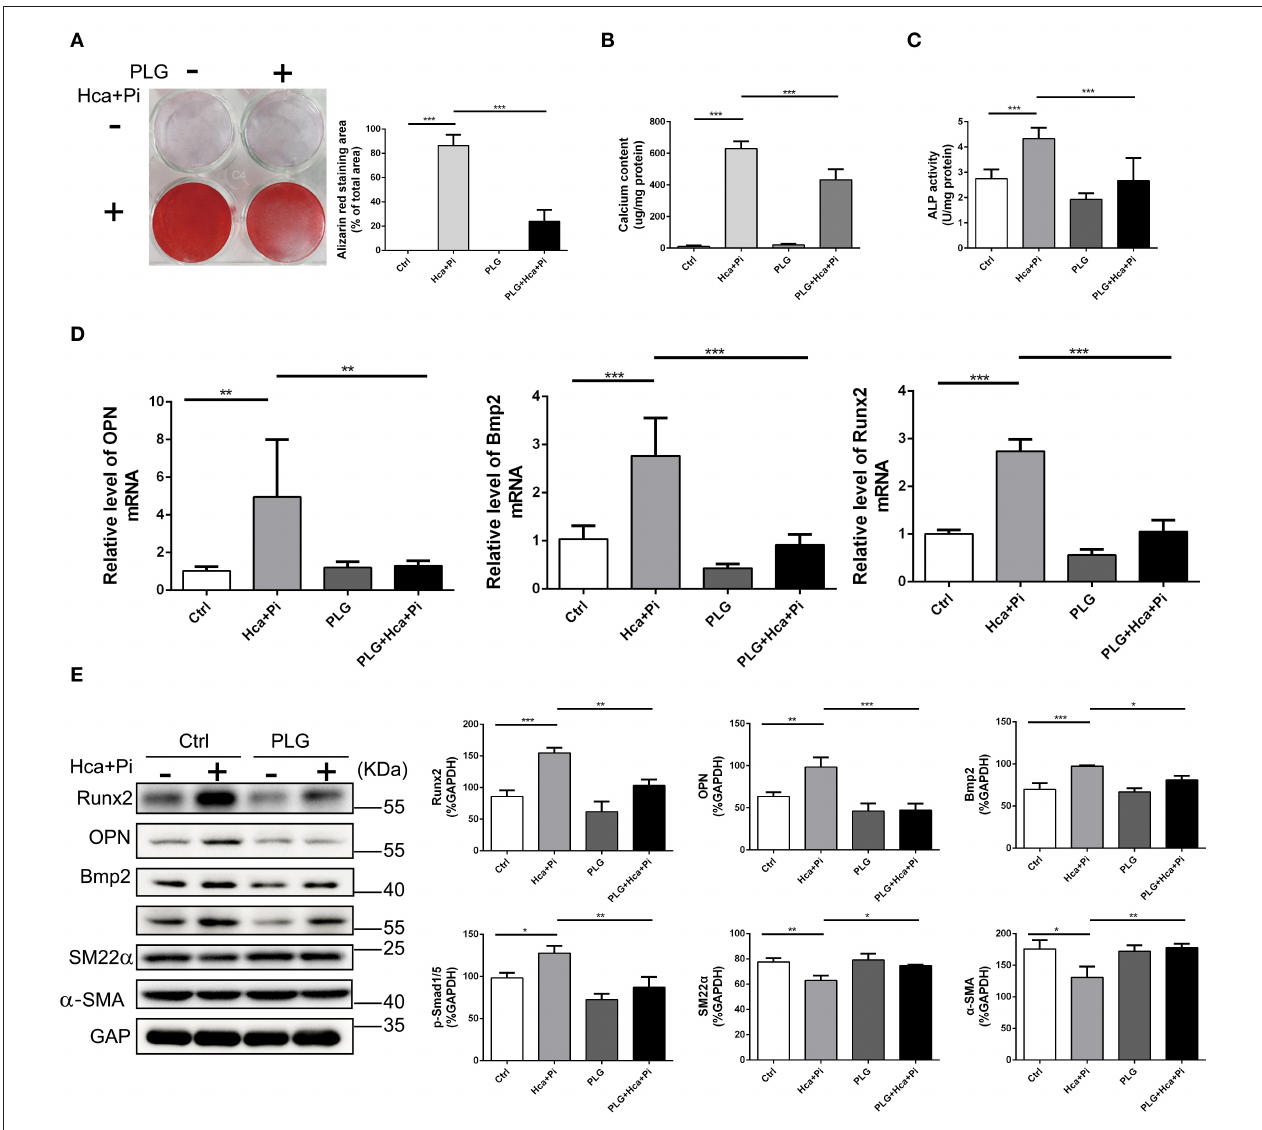
FIGURE 2 | PLG inhibits VSMCs calcification induced by high calcium/phosphate medium. (A) Alizarin Red staining of cellular calcium deposition. The histogram on the right is a statistical analysis of the Alizarin Red staining area. (B) Calcium content was measured with the QuantiChrom TM Calcium Assay Kit. (C) ALP activity was measured with the LabAssay TM ALP Kit. (D) RVSMCs were treated with PLG (2.5 µ M) and high calcium/phosphate. The mRNA levels of Runx2, OPN, and Bmp2 were measured by qRT-PCR ( n = 6 for each group). (E) The protein levels of Runx2, OPN, Bmp2, p-Smad1/5, SM22 α , and α -SMA were measured by western blotting. The relative protein levels were normalized to the level of GAPDH. The data are shown as the mean ± standard error of triplicate sets and are representative of three independent experiments (* P < 0.05, ** P < 0.01, and *** P < 0.001 indicate significant differences between the indicated